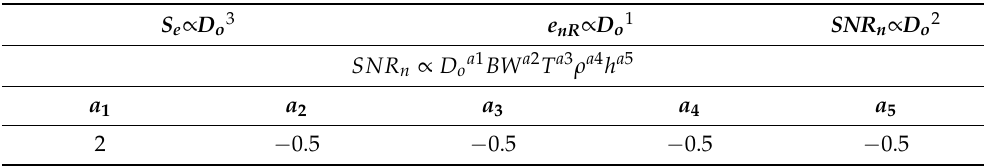
Figure 5. ( a ) The 4D nomogram for SNR * /D o 2 as a function of d i , w , and s provides a novel design guideline for µSCM design optimization. ( b ) The 2D view of part ( a ) shows the existence of a critical normalized inner diameter ( d i ,c ). Table 2. Scaling analysis of µ SCM and a summary of the key parameters’ exponents for sensitivity ( S e ), e nR , and SNR n ( T : temperature; ρ : material resistivity; h : track